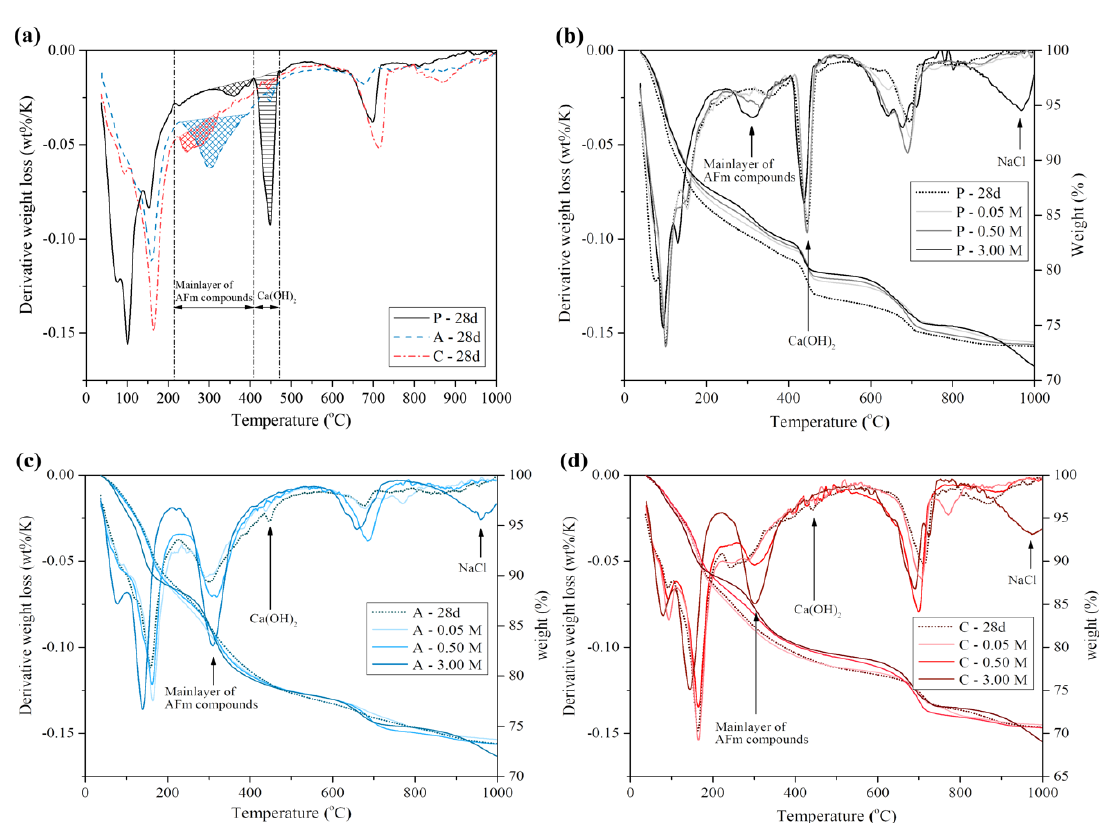
Figure 5. Thermogravimetric analysis (TGA) results of P, A and C ( a ) at 28 days; chloride contaminated samples ( b ) P, ( c ) A and ( d ) C at 0.05, 0.50 and 3.00 M chloride concentrations.